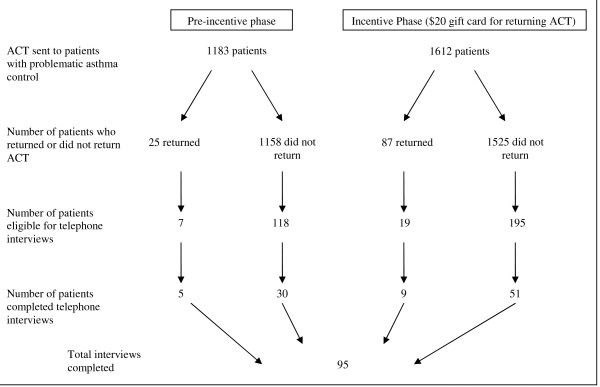
Overall schematic of study. During the pre-incentive phase, of 1183 patients with evidence of problematic asthma control and were sent mailings containing the ACT, 25 returned the ACT. During the incentive phase, 87 patients out of 1612 patients returned the ACT. During the pre-incentive phase, 125 patients were eligible for telephone interviews, and during the incentive phase, 214 patients were eligible. The main reason for ineligibility was lack of an accurate phone number of address. A total of 95 telephone interviews were completed.